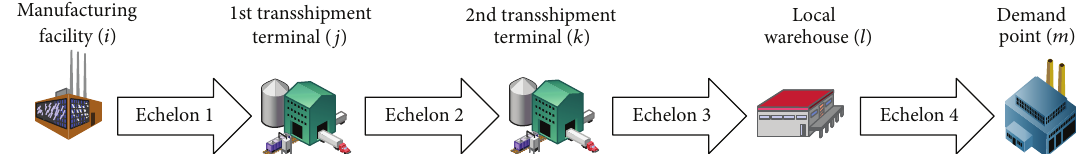
Figure 1: Proposed methodology.